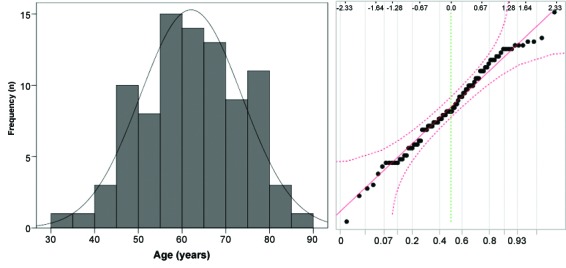
Patients (n = 89) with venous ulcers treated at the Dermatology Service, Faculdade de Medicina de Botucatu, Universidade Estadual Paulista (UNESP), SP, Brazil: histogram and Q-Q plot for age in years.